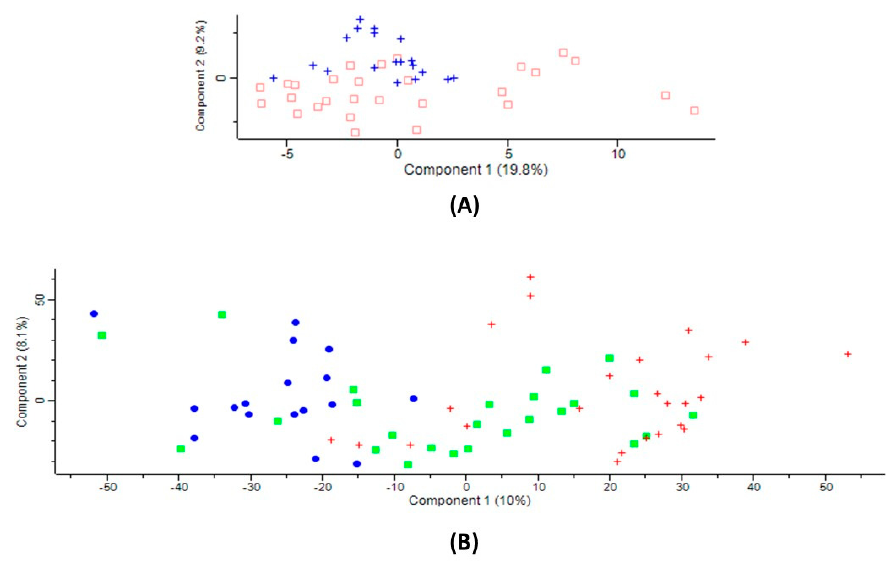
Figure 1. Principal component analysis (PCA) of the LFQ intensities for serum proteins: ( A ) cystathionine β -synthase (CBS)-deficient patients (blue) and unaffected controls (red); ( B ) patients with cardioembolic (blue oval), large-vessel (green square), or lacunar (red cross) ischemic stroke subtype. Calculations were carried out using Perseus.